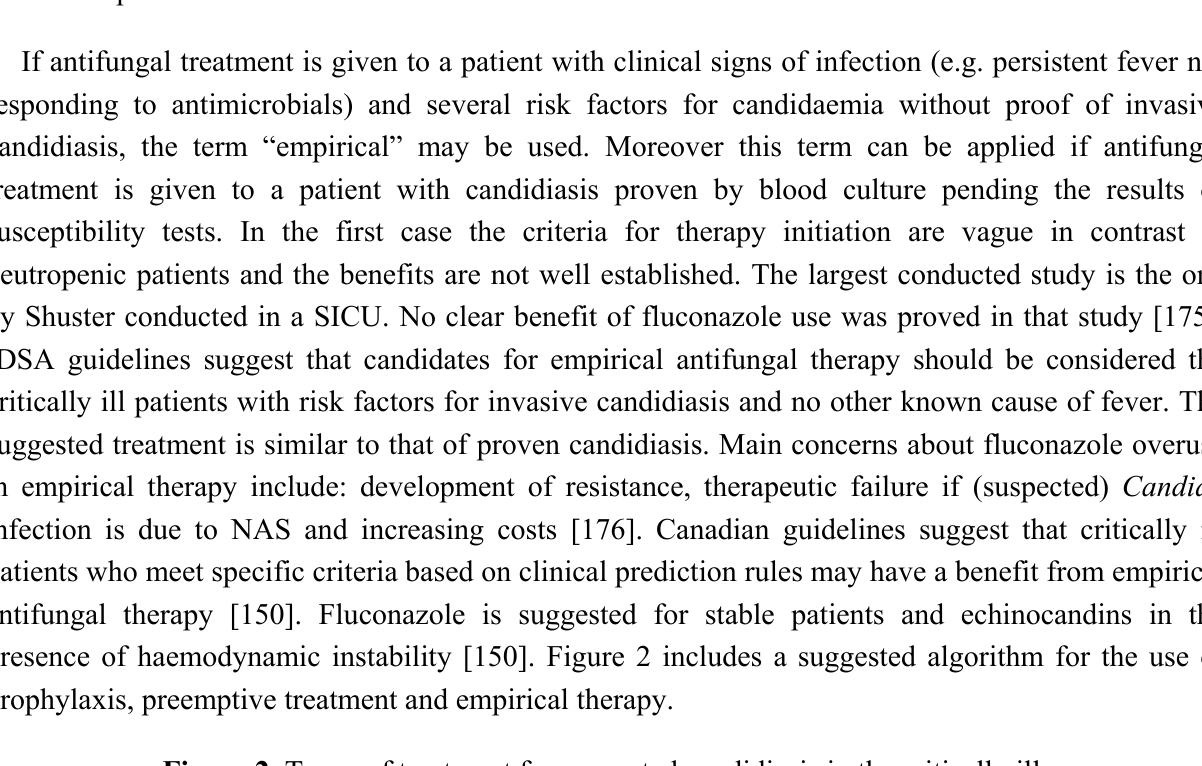
Figure 2. Types of treatment for suspected candidiasis in the critically ill.